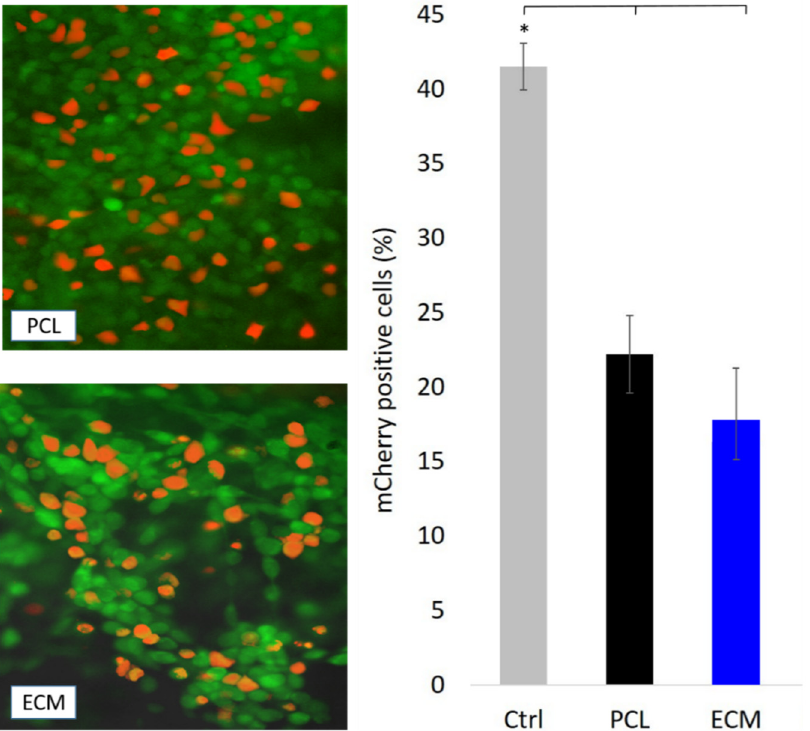
Figure 4. Transfection efficiency of HepG2 cells growing on PCL and ECM scaffolds. The cells were transfected with plasmid carrying red fluorescent protein (RFP) gene. Fluorescein-diacetate was applied to visualize the viable cells (green). Red and orange cells are producers of RFP (left), i.e., successfully transfected cells. Transfection efficiency of cells growing as monolayer on culture dish surface (Ctrl) and cells growing on the scaffolds is presented with bar chart (* p value < 0.05). There was no significant difference in the number of transfectants between two tested scaffolds.